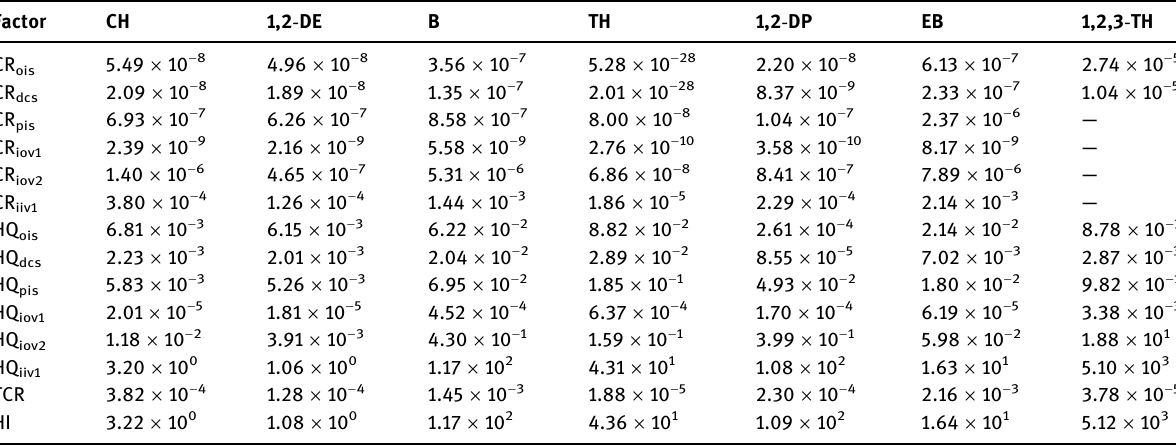
Table 5: Health risks for each contaminant and exposure pathways